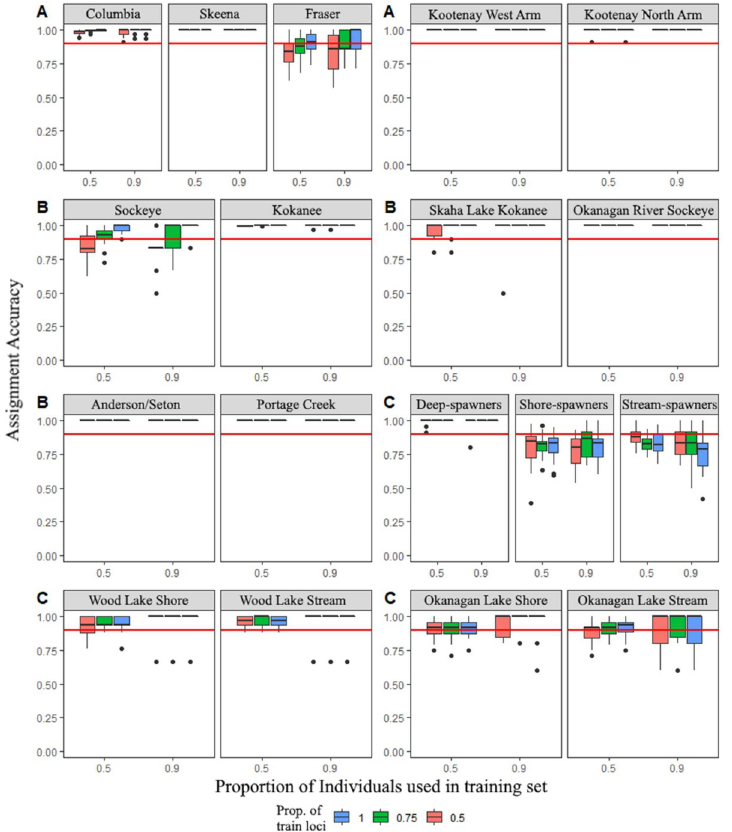
Fig 4. Assignment accuracies estimated using the support vector machine algorithm with Monte-Carlo cross- validation implemented in assignPOP [50]. Sampling of subsets of high θ loci (all loci, blue; top 75%, green; top 50%, orange) are crossed by two levels of training individuals (50%, 90%). Outliers are shown as black circles. The horizontal red line indicates 90% assignment rate. Results grouped by: A: geographic basin, B: migratory form, C: reproductive